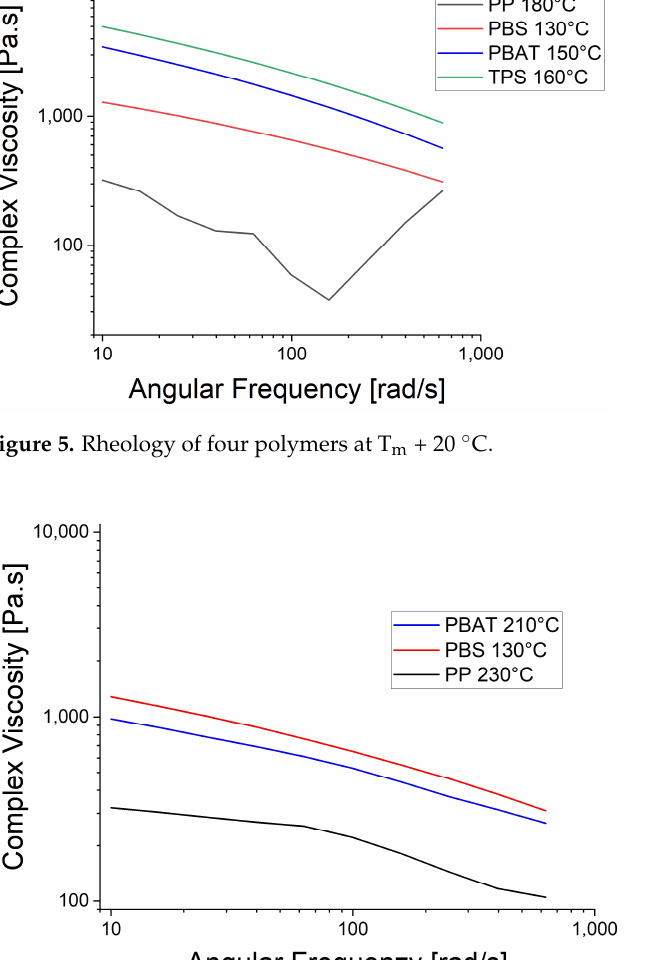
Figure 5. Rheology of four polymers at T m + 20 °C.